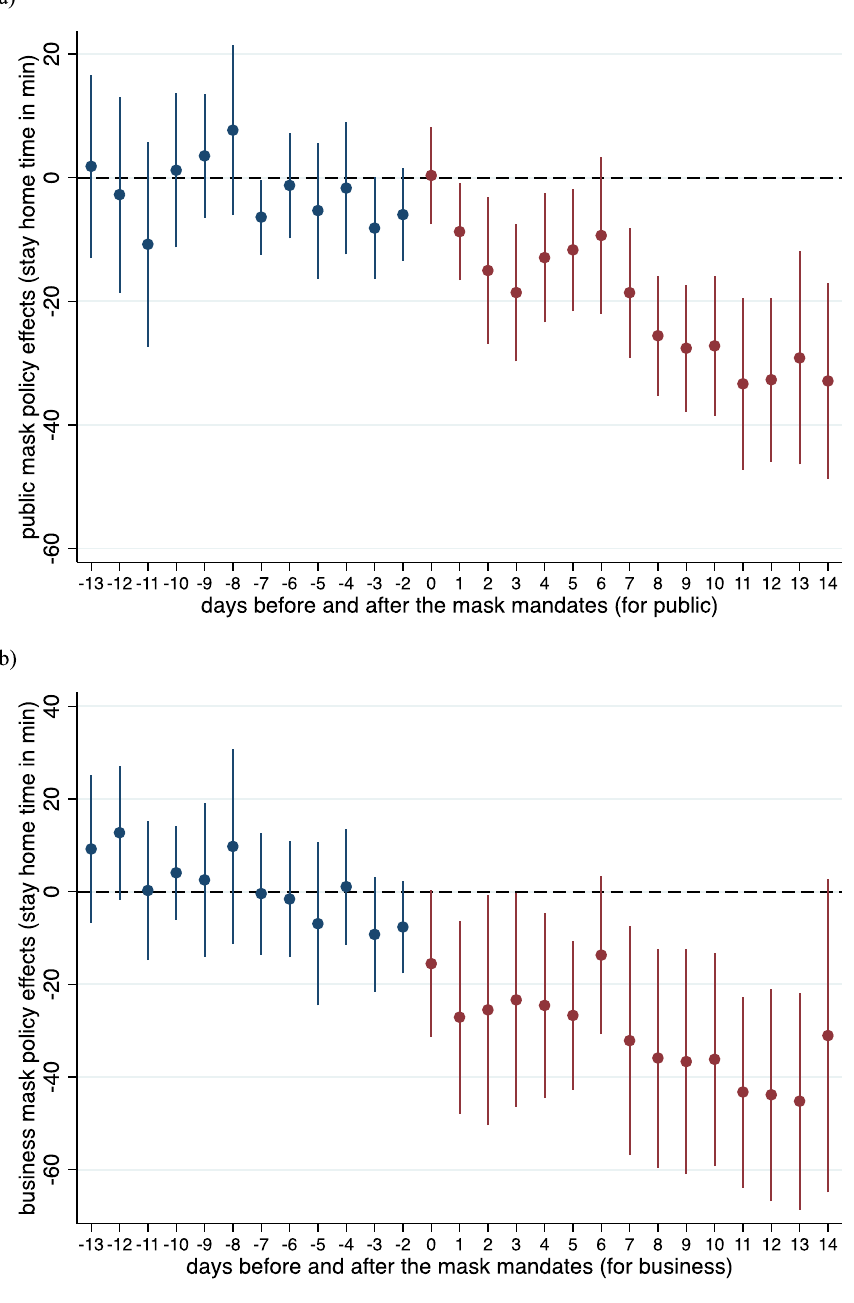
Figure 2. Dynamic mask mandate effects in 14 days before and after the mandates ( a ) for public and ( b ) for business. Blue is pre-mandate implementation and red is post-mandate